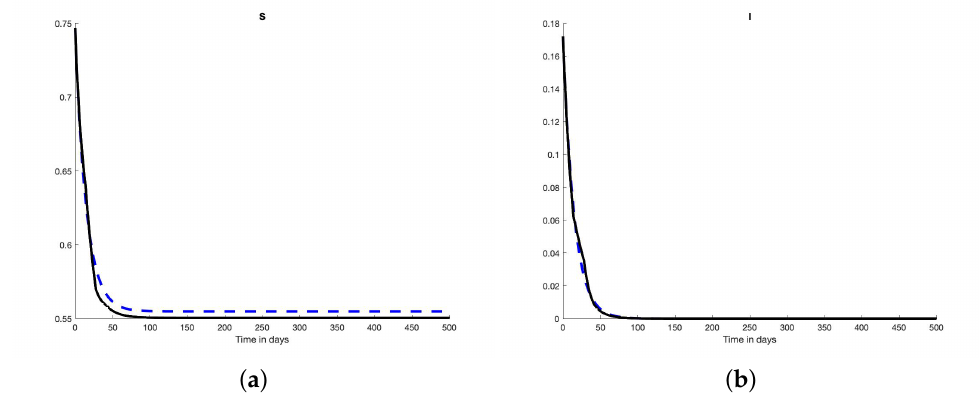
Figure 15. Scenario 6: Control. β , β ∗ (- -,blue), γ (- ., green) and β acceptable (- -, black).